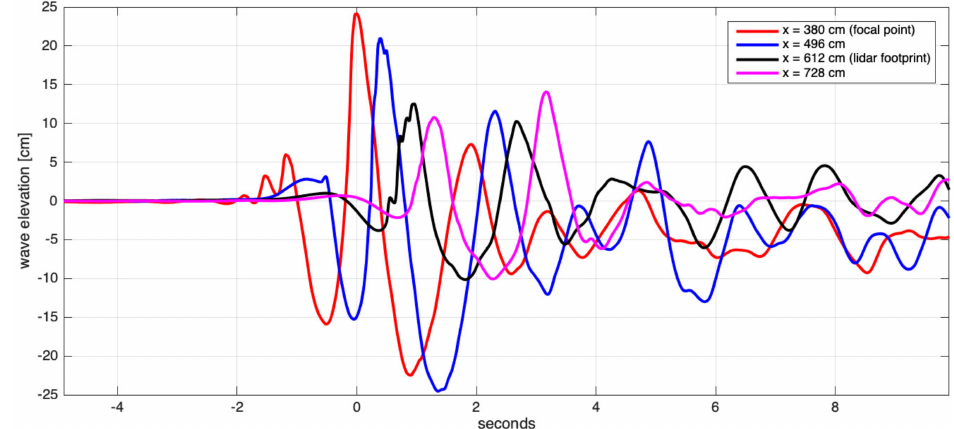
Figure 2. Time series of wave elevation measured at four locations along the center line of the tank.